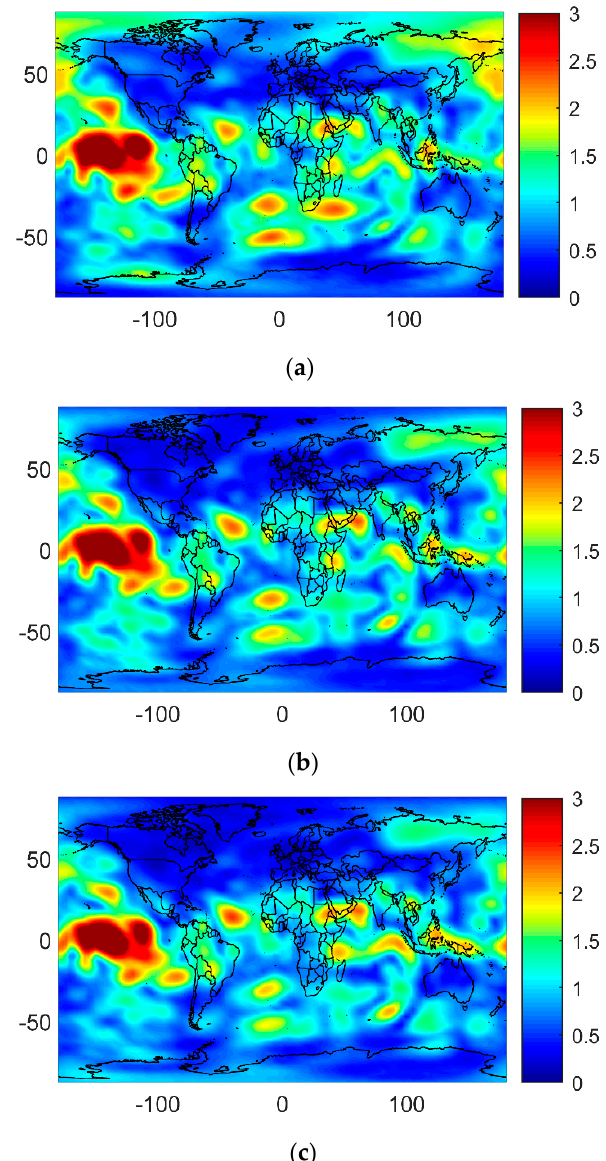
Figure 9. Difference distributions of the VTEC values of the CCL ( a ), PPP-float ( b ), and PPP-AR ( c ) methods compared to that of CODE GIM products on DOY 100, 2017. Table 6. Averaged RMS of VTEC differences for the CCL, PPP-float, and PPP-AR methods compared to CODE final GIM products.